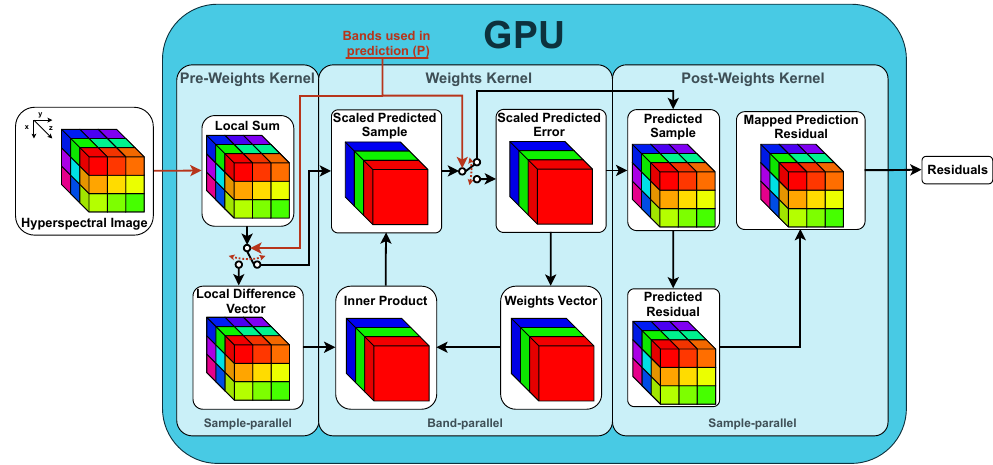
Figure 1. Proposed architecture for Consultative Committee for Space Data 19 Systems (CCSDS)-123 parallel 3D predictor. The switch determines the predictor’s mode of operation. In the current position, the predictor executes intra-band prediction mode ( p = 0), while, for inter-prediction ( p > 0), the two switches move to the other position, including several bands in the predictor. The weights kernel achieves band-level parallelism while the remaining kernels execute with sample-level